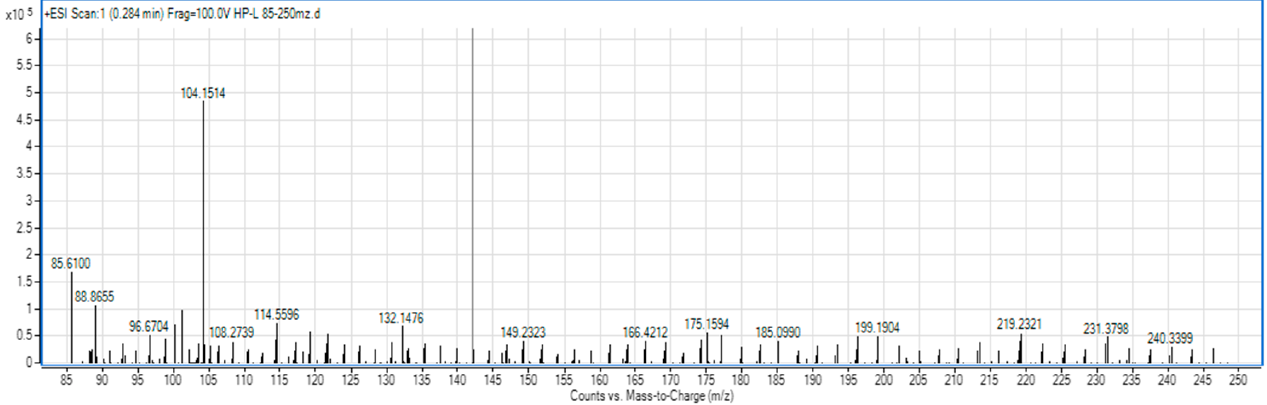
Figure 3. The spectrum of the hydrolysate sample in the domain 85–250 m / z .